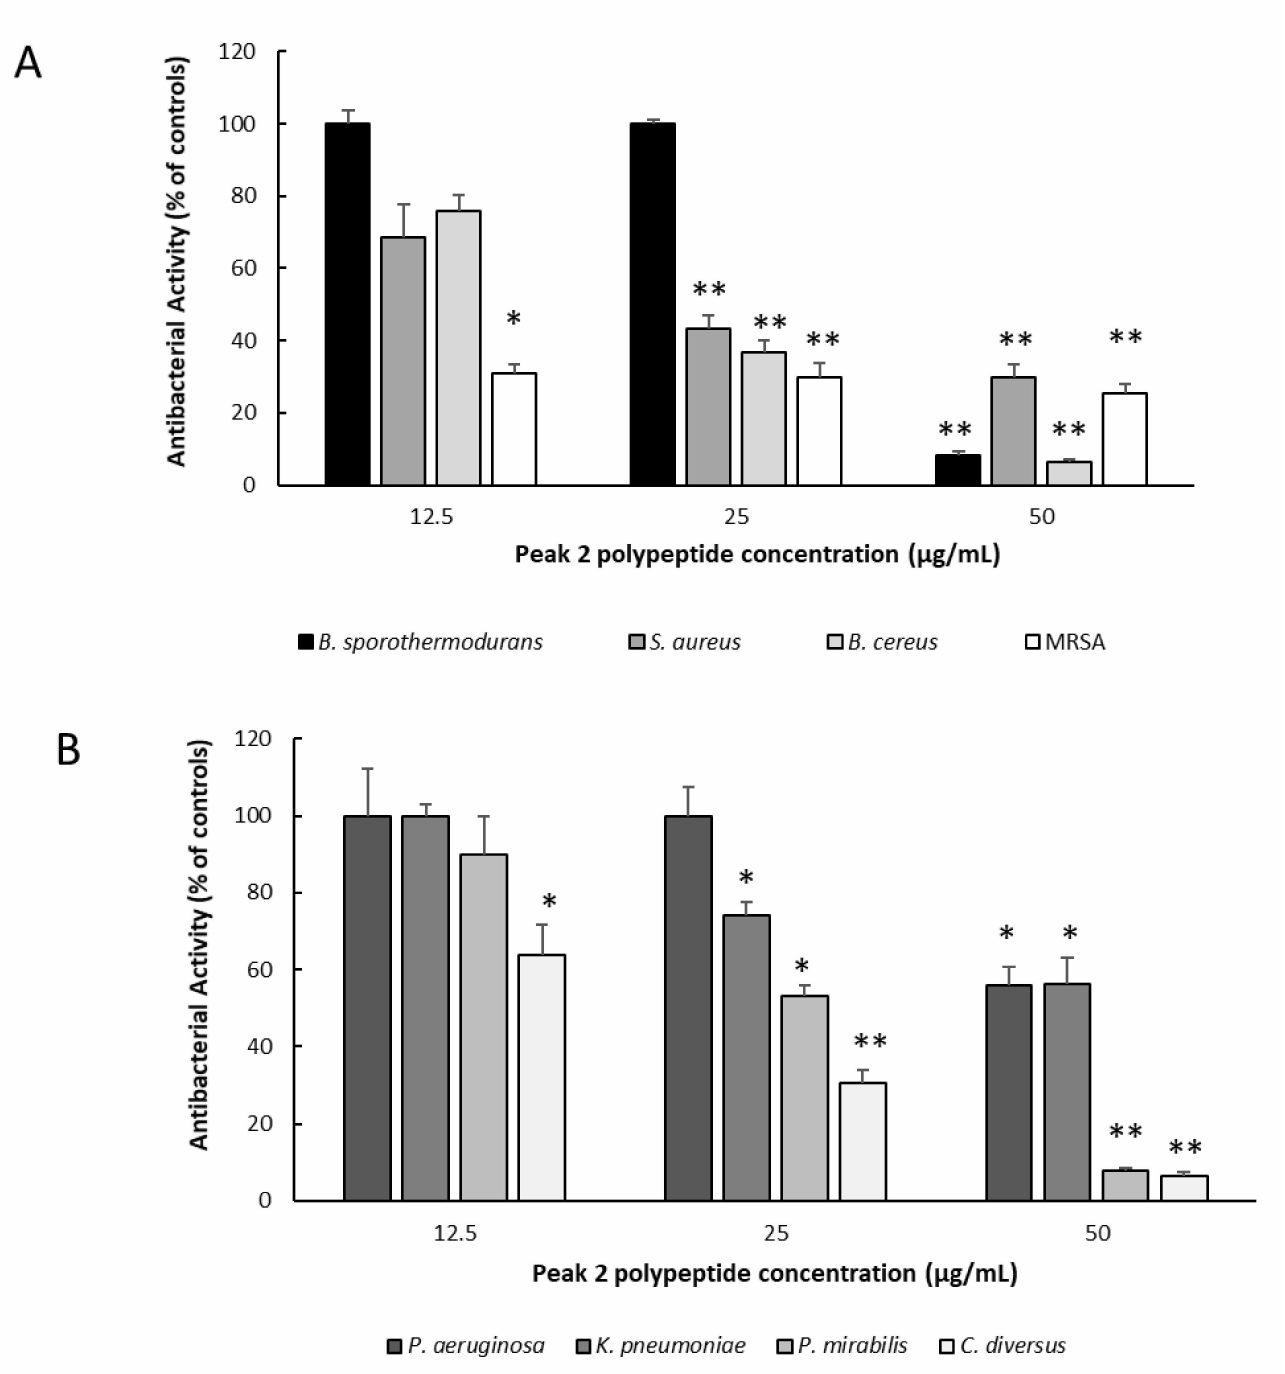
Figure 5. Peak 2 polypeptide antibiotic activity against several pathogens related and not related to food. ( A ) Gram-positive bacteria ( Bacillus cereus , Bacillus sporothermodurans , Staphylococcus aureus , and methicillin-resistant Staphylococcus aureus ); ( B ) Gram-negative bacteria ( Citrobacter diversus , Klebsiella pneumoniae , Proteus mirabilis , and Pseudomonas aeruginosa ). Bacterial growth in each strain is expressed as % of controls ± SD. ** p < 0.001, * p <